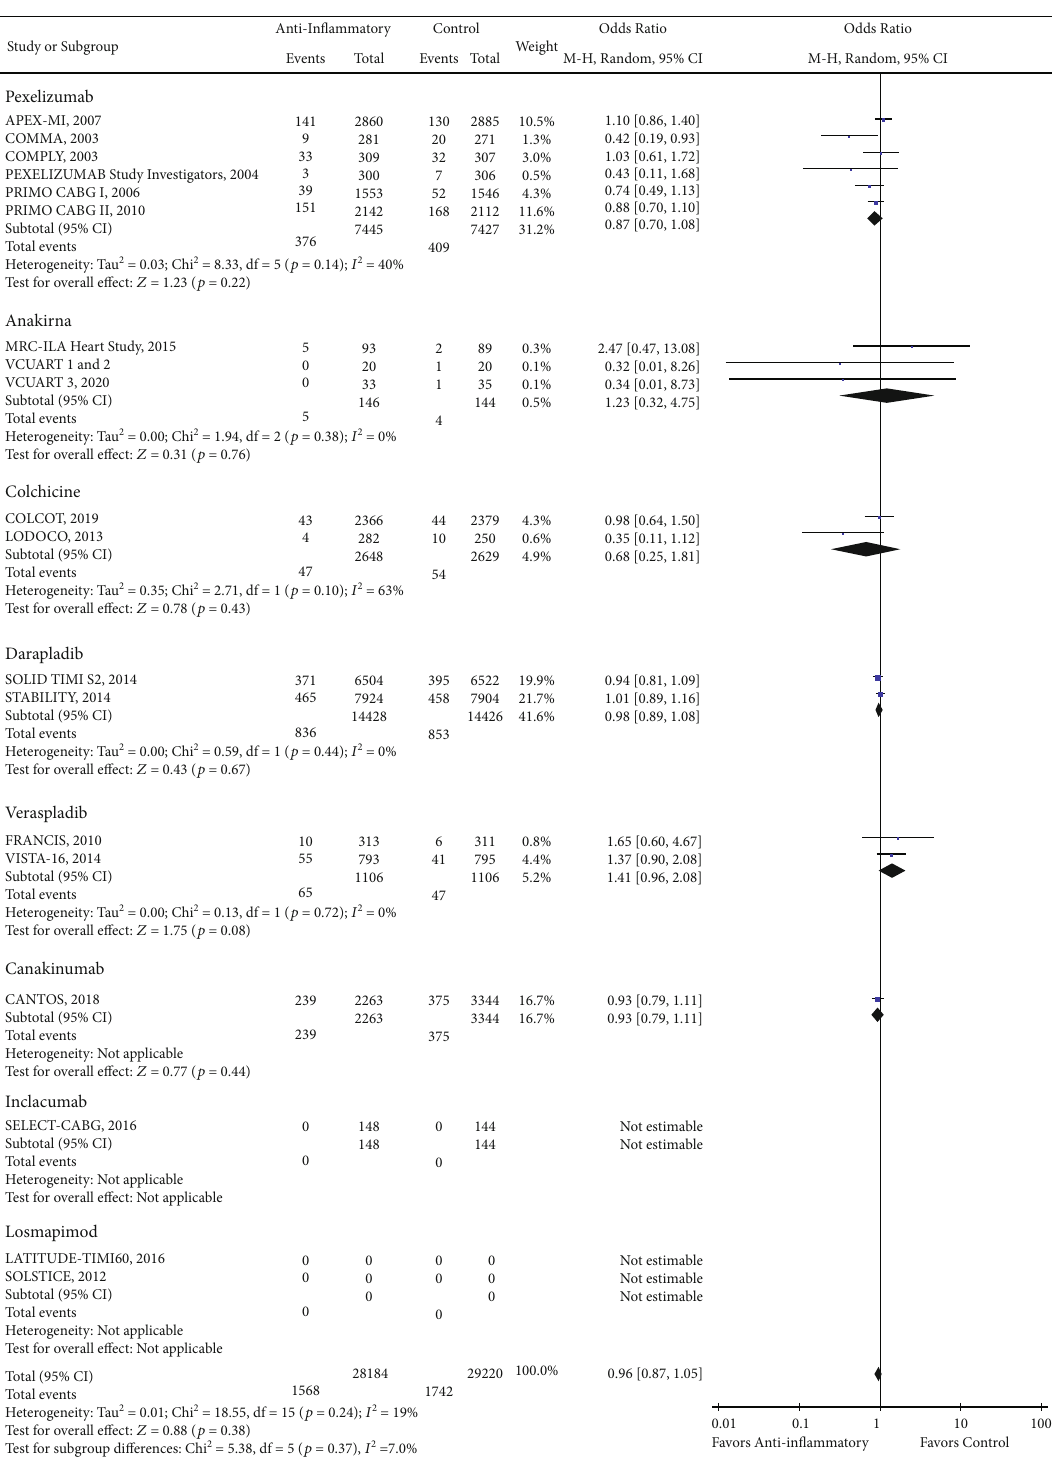
Figure 4: Forest plot of all-cause mortality. No signi fi cant di ff erence was observed in the risk of all-cause mortality between anti- in fl ammatory therapy and standard therapy alone (OR 0.96, CI 0.87-1.05; P = 0 : 38